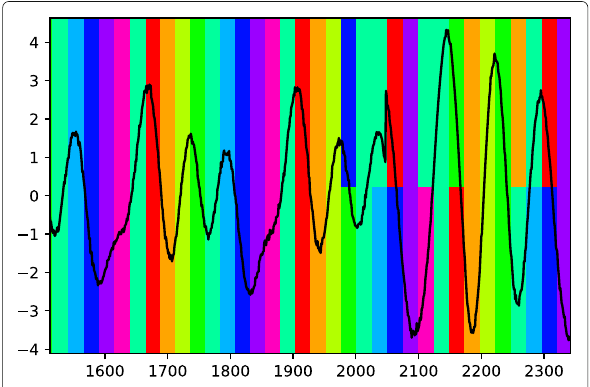
Fig. 10 Classifier with n 0 = 10, n n 0 = 9 applied to wave with abnormal amplitudes starting at time stamp 2048